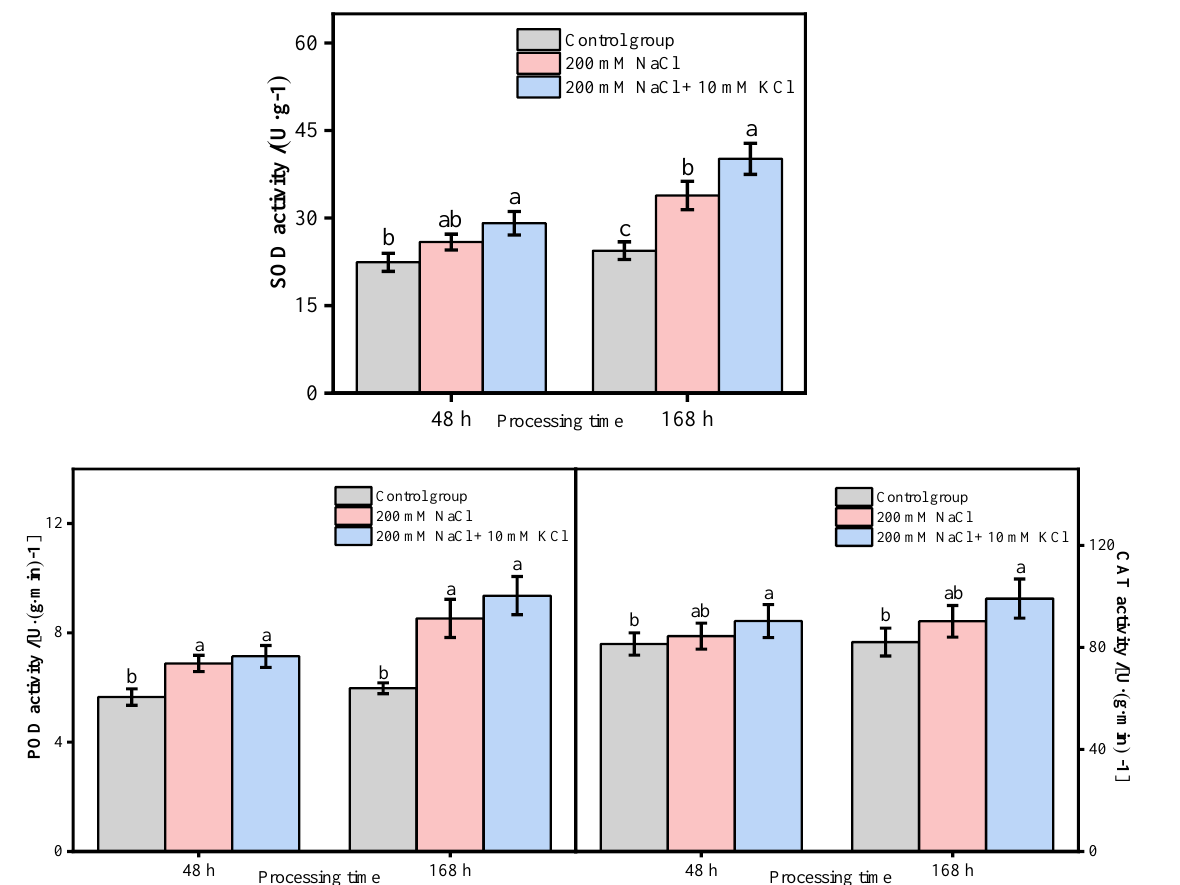
Figure 3. Changes of SOD, POD and CAT activities in leaves of T . ramosissima under different treatments. Changes of SOD, POD and CAT activities in leaves of T. ramosissima at 48 h and 168 h under different treatments. Note: different letters indicate the significance of differences among treatments at the same time, p < 0.05. There were 3 biological replicates applied for all determination.